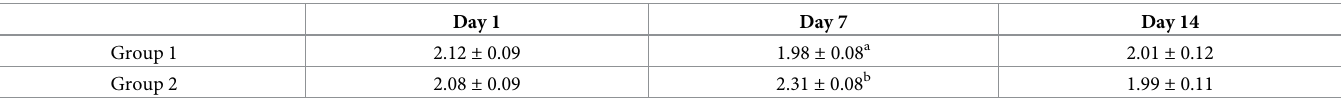
Table 3. Total immunoglobulin A (IgA) concentration (mg/g) in the faeces of hamsters fed a basal diet (group 1) and a 1.0 × 10 ⁷ cfu/ml supplement of heat-killed Enterococcus faecalis (group 2).